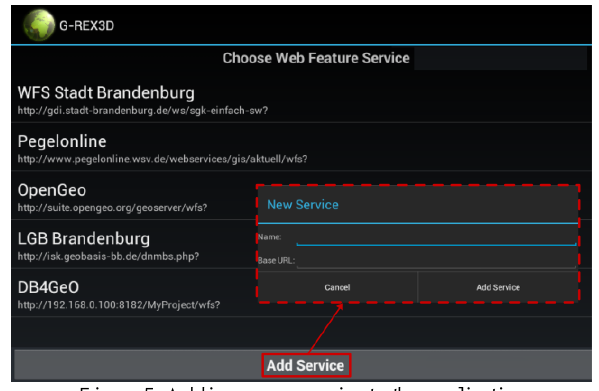
Figure 5: Adding a new service to the application